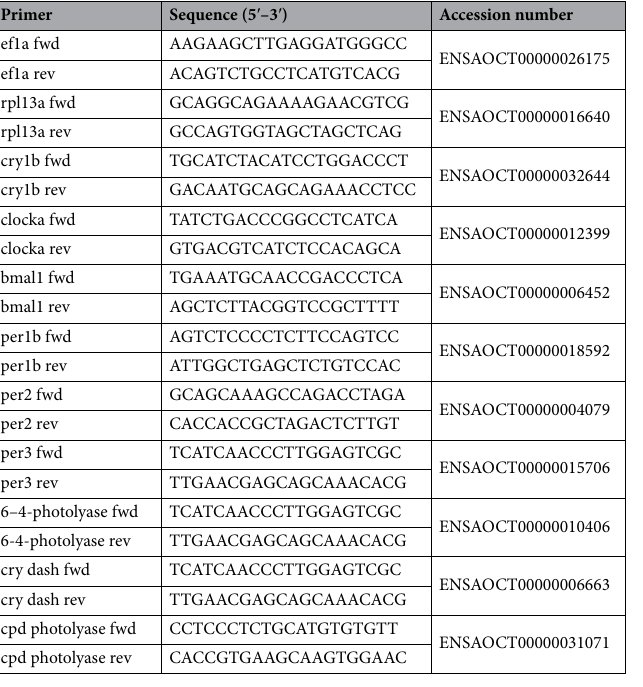
Table 1. Primers used for quantitative real time PCR to analyse gene expression. Primers were designed using Primer3 based on sequences obtained from ensembl.org (Accession Number) originating from 27 . Ef1a and rpl13a are used as housekeeping genes, cry1b , clocka , bmal1 , per1b , per2 and per3 are elements of the core clock mechanism. 6-4-photolyase , cry dash and cpd photolyase constitute the photoreactivation DNA repair